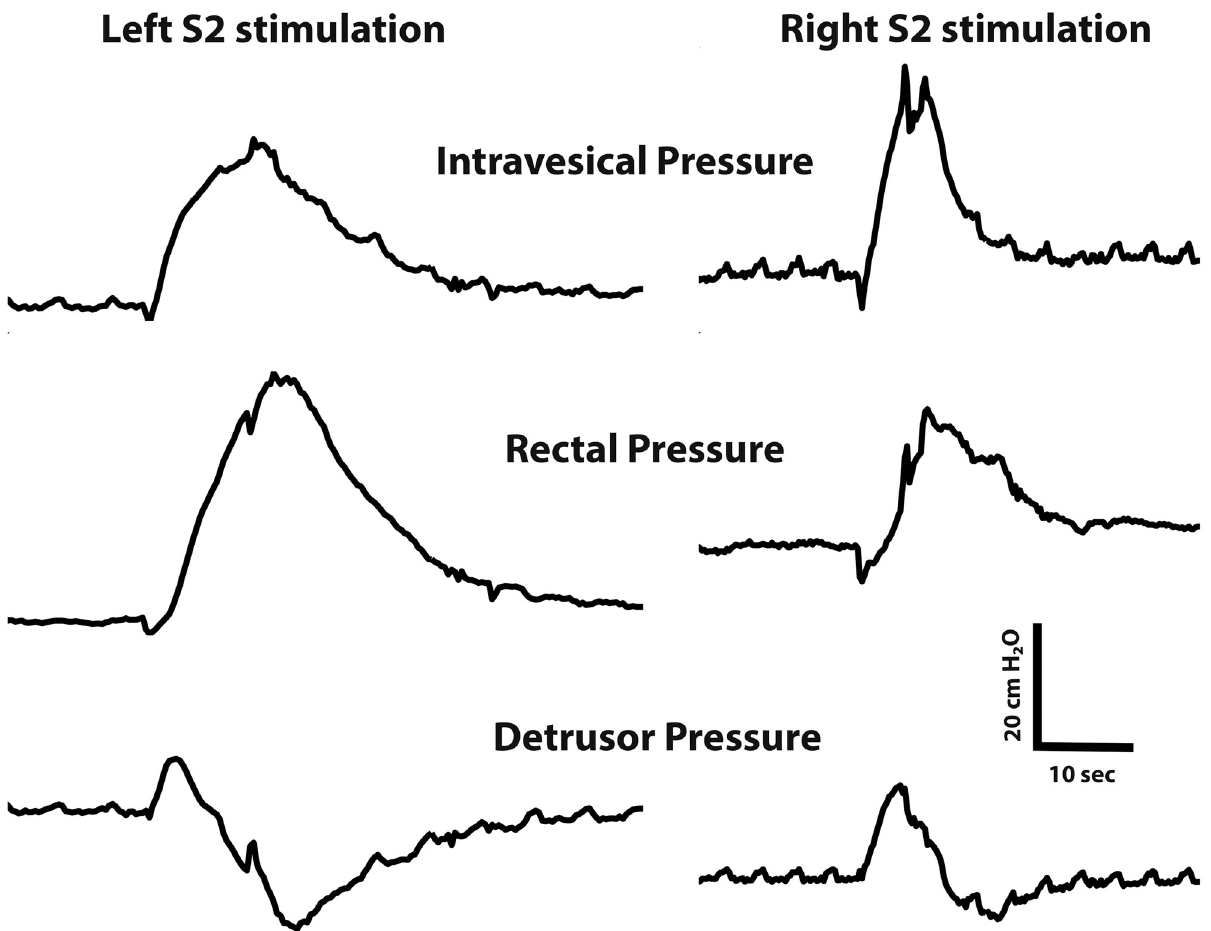
Fig 1. Left and right pressure recording of S2 spinal root stimulation. Representative example of a recording of intravesical, rectal and detrusor pressure during stimulation of the S2 spinal root. Pressure is measured in cm H 2 O.